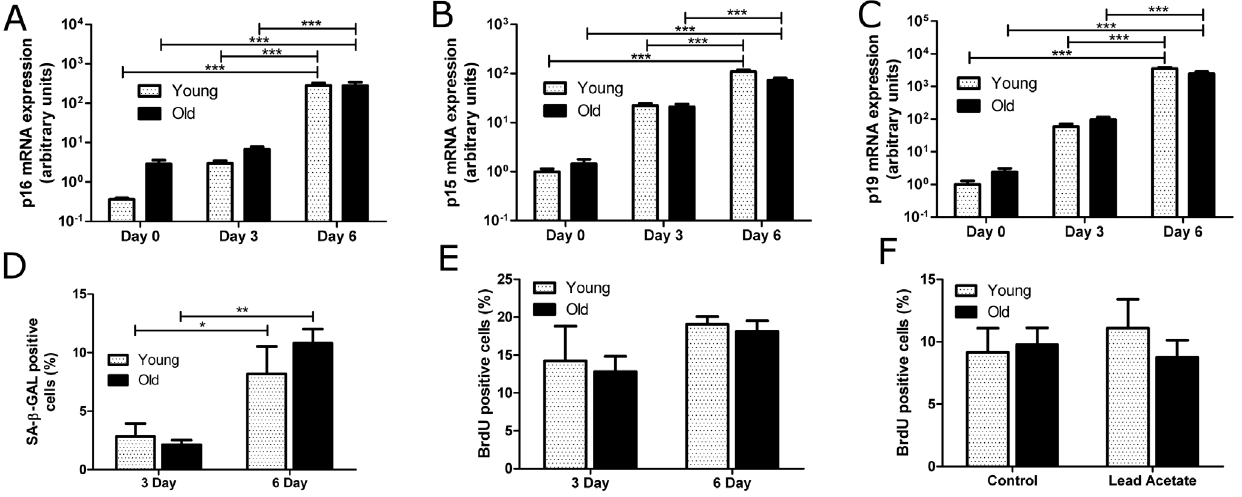
Figure 5. Invitro culturing of primary tubular epithelial cells (PTEC) induces SCS-associated changes. PTEC were isolated from young and old mice and harvested on day 0, day 3, or day 6 of culture. Quantitative PCR for (A) p16 INK4a (B) p15 INK4b , and (C) p19 ARF in PTEC. (D) Quantification of SA- b -GAL staining on day 3 and 6 of PTEC culture. (E) Quantification of cells stained positive for BrdU on day 3 and 6 of PTEC culture. (F) BrdU uptake after lead acetate treatment in PTEC from young and old mice on day 6 of culture. n= at least 4 separate mice, data are mean values 6 SEM. *P , 0.05; **P , 0.01; ***P , 0.001.